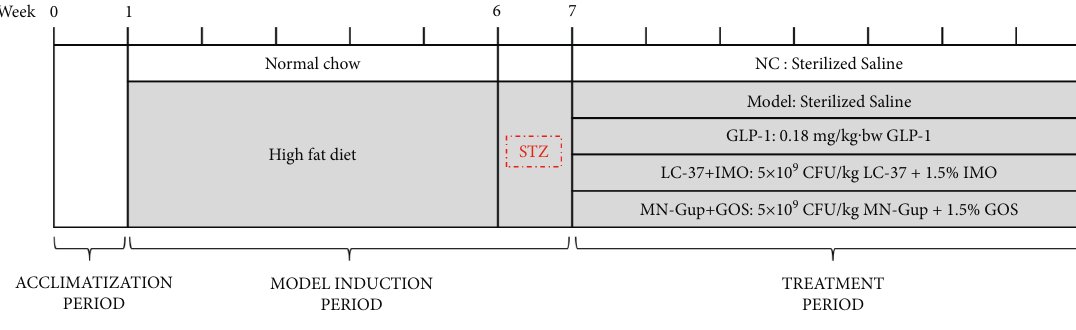
Figure 1: Experimental design.